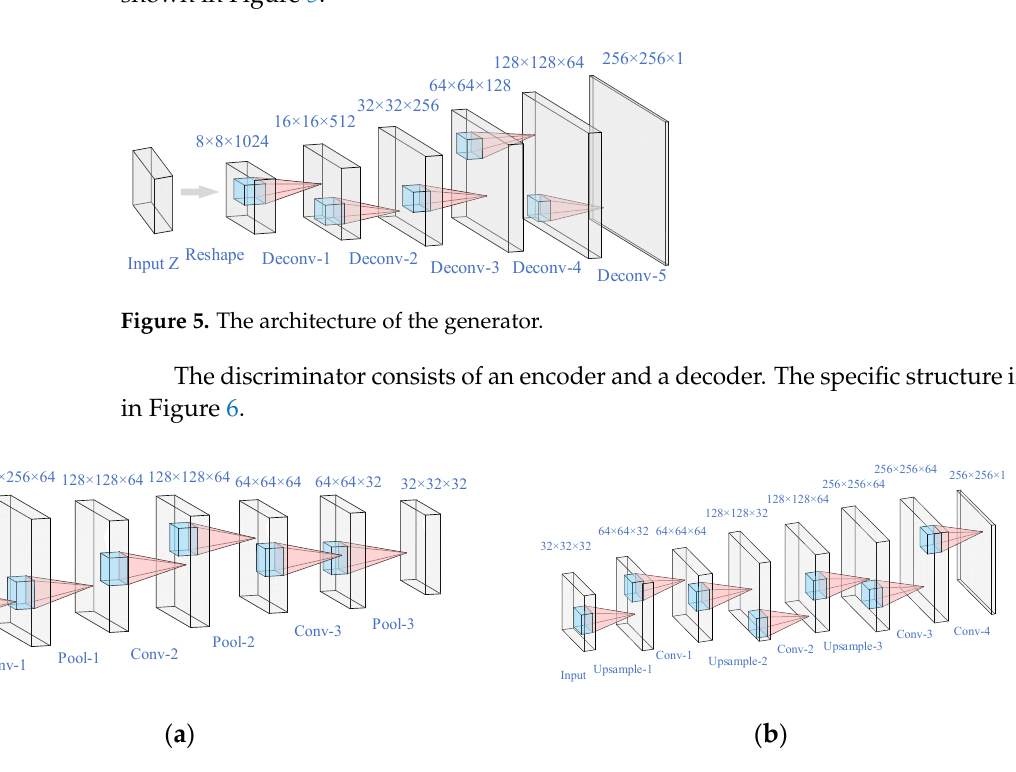
Figure 5. The architecture of the generator.